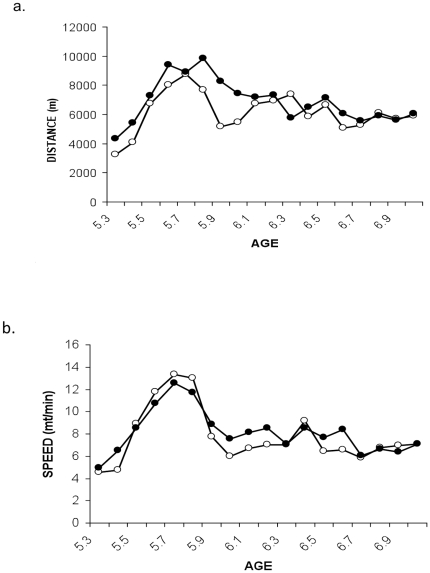
Exercise parameters of mice fed HF and HP diets.Mice were received at age 5-weeks and fed HF for 4.5 months as described in Methods. At this time half of the mice were randomly assigned to continue on the HF diet and half were weaned off the HF diet onto the HP diet as described in Methods. At the same time half of the mice from each diet (10 mice per group) were randomly assigned to exercise by housing in individual cages with computer-monitored exercise wheels or remained sedentary also in individual cages without wheels. Running was monitored continuously. Each point is the mean of 10 mice per group; exercised mice only. After a lag period and slight overshoot, mean running distance stabilized at 6-km per day. Open circles HP; closed circles HF.